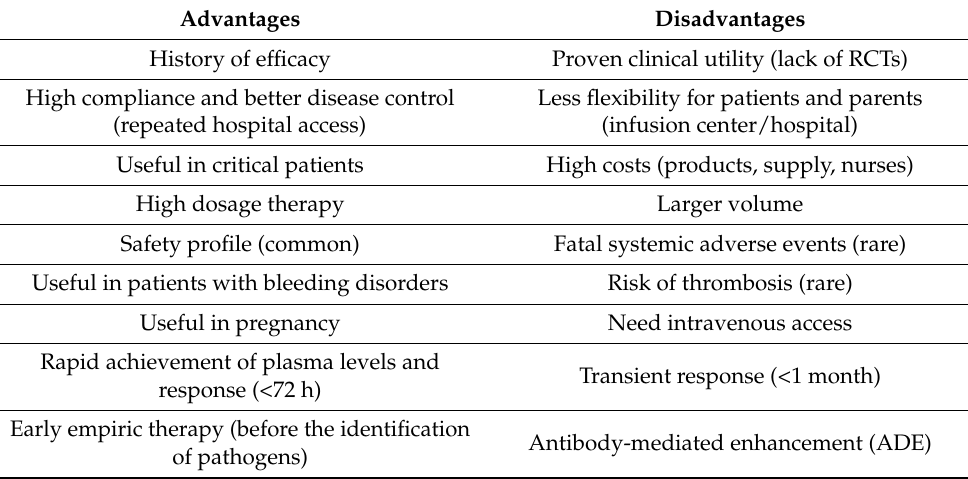
Table 3. Advantages and disadvantages of IVIG therapy in infectious